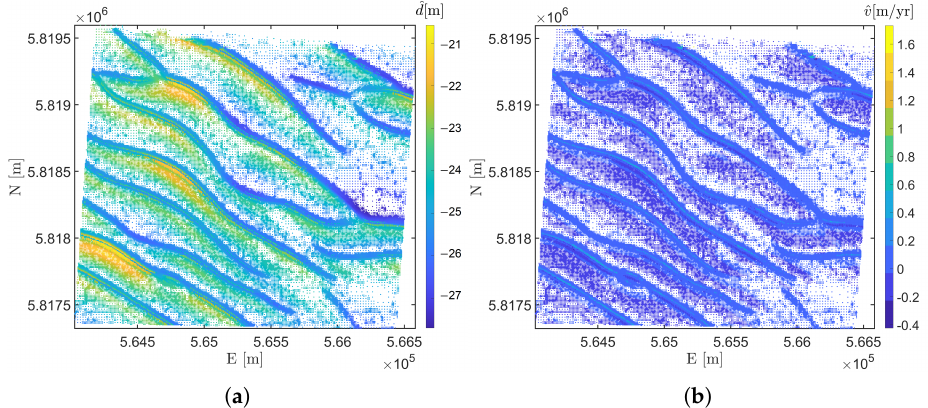
Figure 12. Estimated parameters of the final model selection: ( a ) Estimated depth, ˆ d and ( b ) Estimated slope, ˆ v .